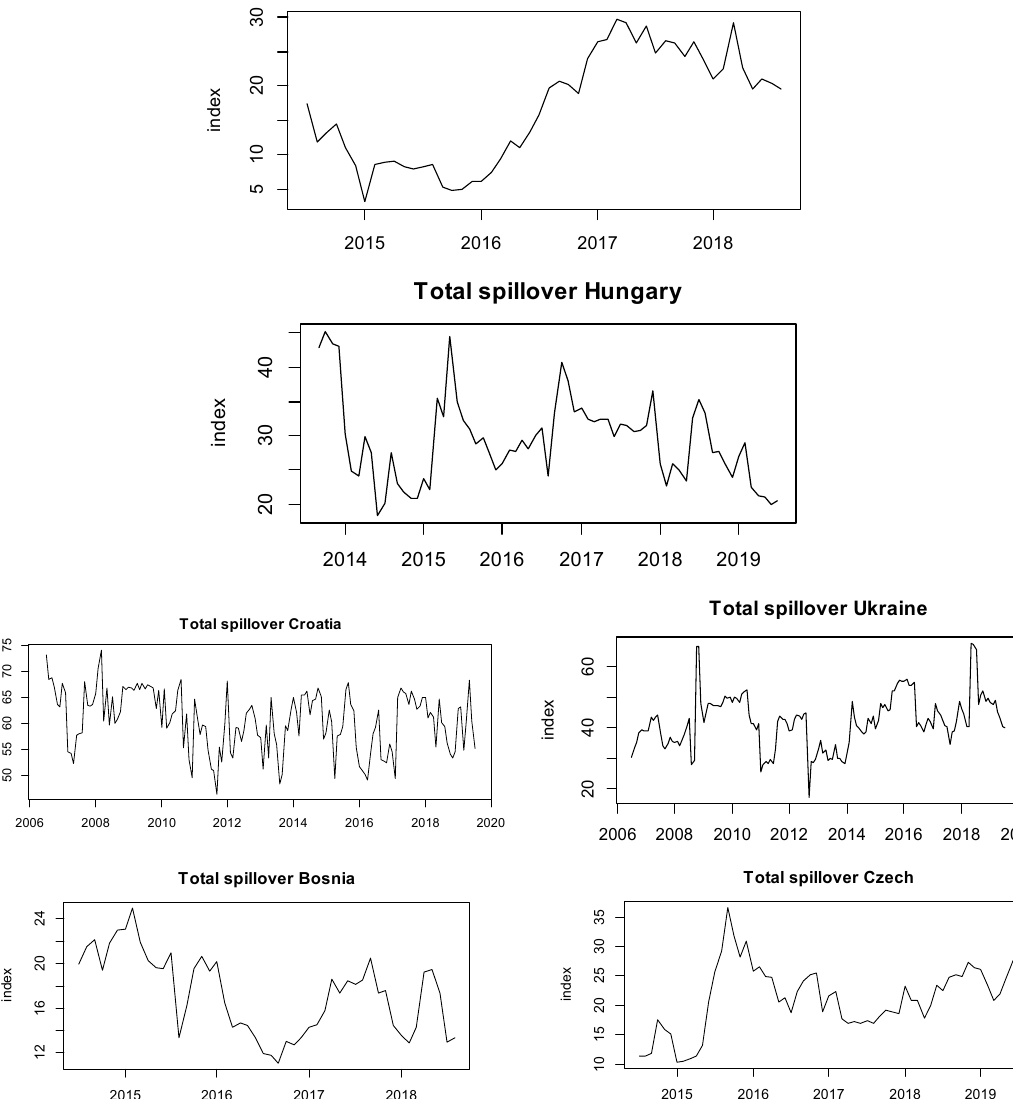
Figure 1. Total spillover indices (from top to bottom, left to right): Serbia, Hungary, Croatia, Ukraine, Bosnia and Herzegovina and Czech Republic.